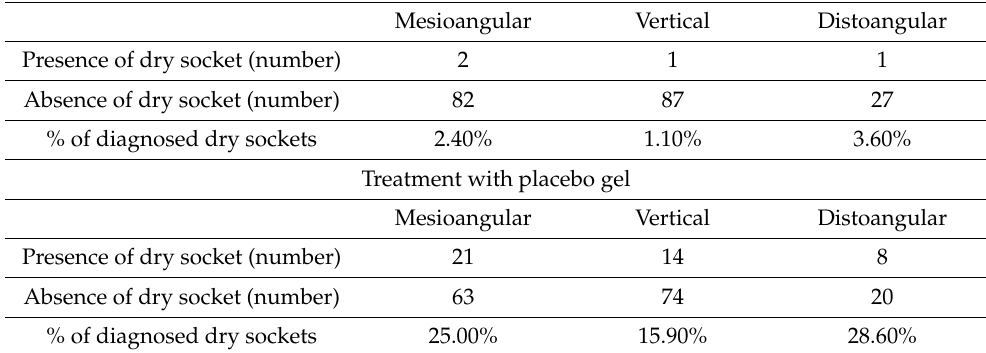
Table 4. The table displays the number of diagnosed dry sockets with respect to the third molar Winter’s Classification after treatment with ozone in the form of sunflower-oil-based gel (Ozosan) or placebo gel. The incidence percentage of dry sockets was calculated with respect to the number of mesioangular (84), vertical (88) or distoangular (28) classified third molars. The * symbol denotes a statistically significant difference ( p < 0.05) between the two treatments, as calculated using the chi-square test.